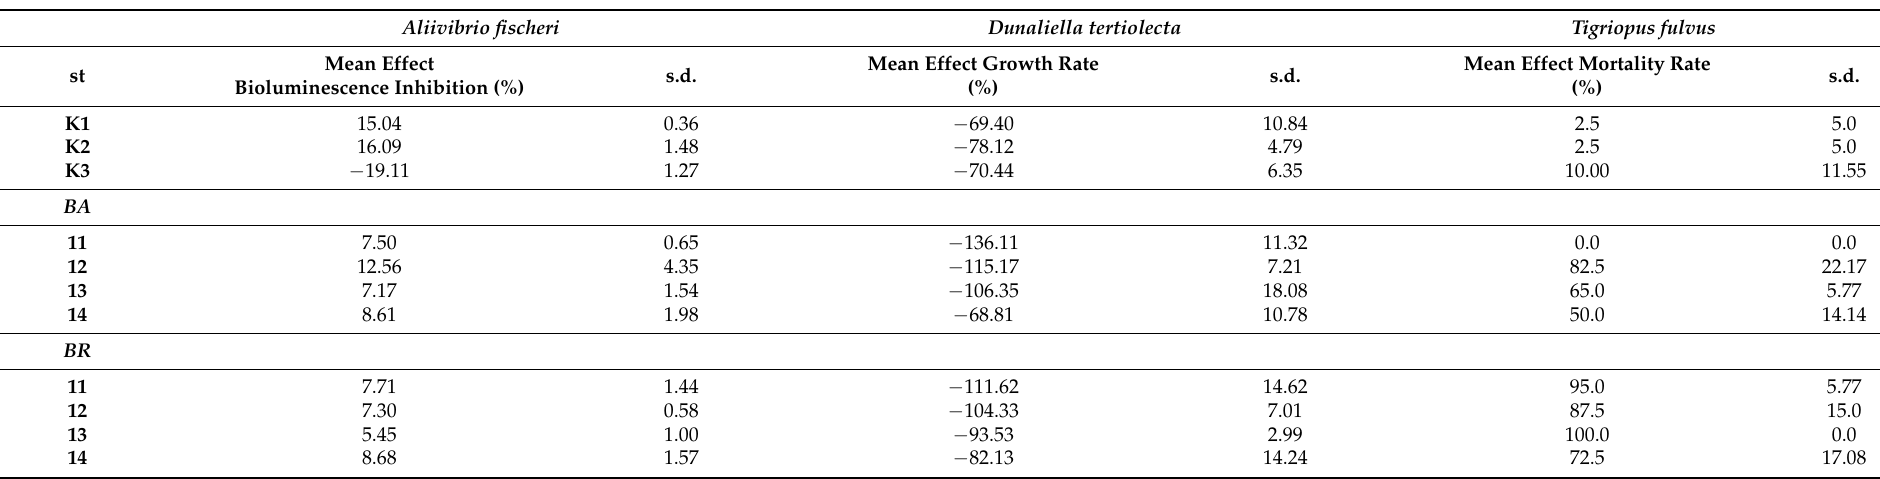
Table 5. Results of bioassays in marine species exposed to pore water of sediment sampled around offshore platforms called BA and BR and control sites. Negative values denote